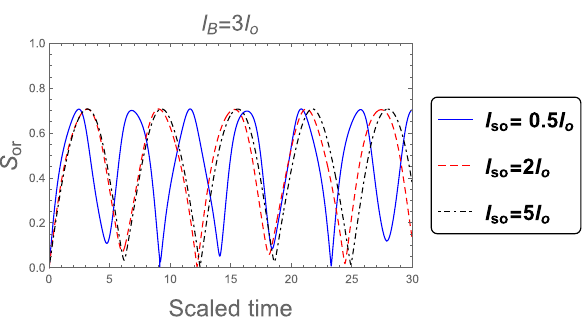
3 l o is applied. =